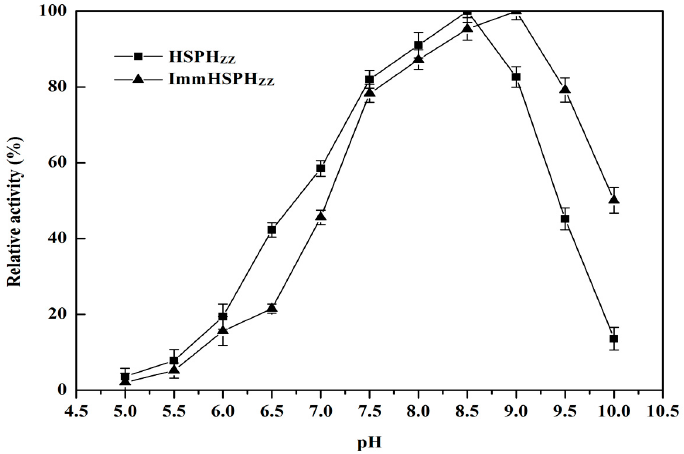
Figure 3. Temperature optima of HSPH ZZ and ImmHSPH ZZ . The buffers (20 mM) used: sodium acetate (pH 5.5–6.0), sodium phosphate (pH 6.5–7.5), Tris-HCl (pH 8.0–9.0) and N -cyclohexyl-3- aminopropanesulfonic acid (pH 9.5–10.0).